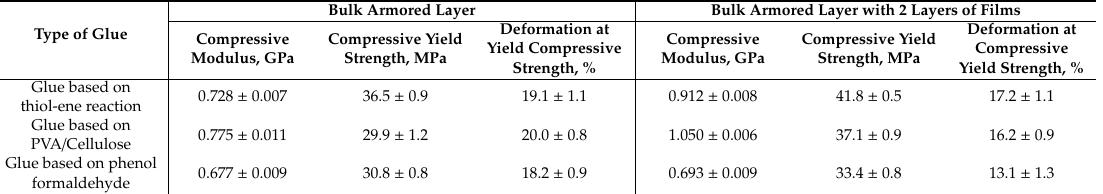
Table 4. Mechanical test results for the armored layers of the cylindrical multi- UHMWPE forms samples according to ASTM